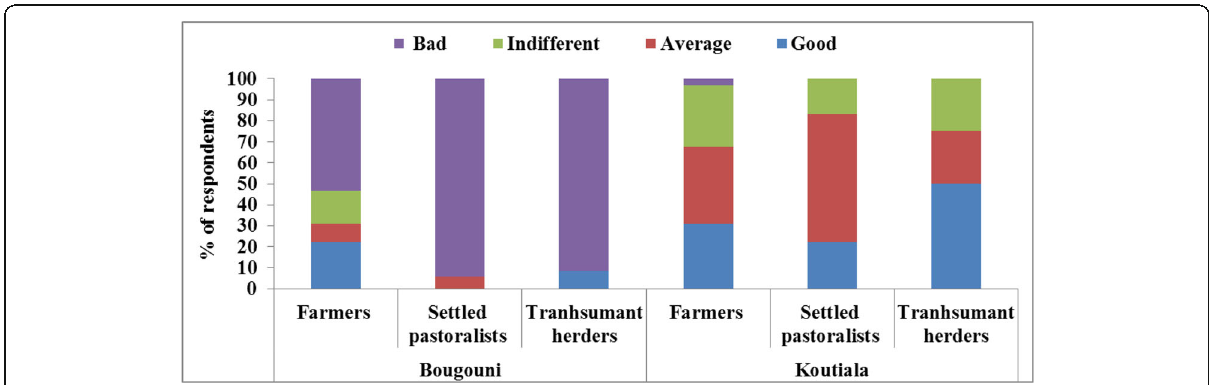
Figure 2 Perception of respondents on social relation between transhumant herders and host